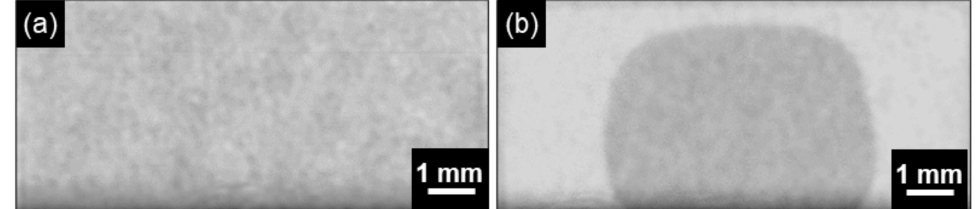
Figure 12. Scanning acoustic tomography (SAT) images of non-shear-tested bonding samples: ( a ) Before thermal shock testing (1000 cycles); ( b ) After thermal shock